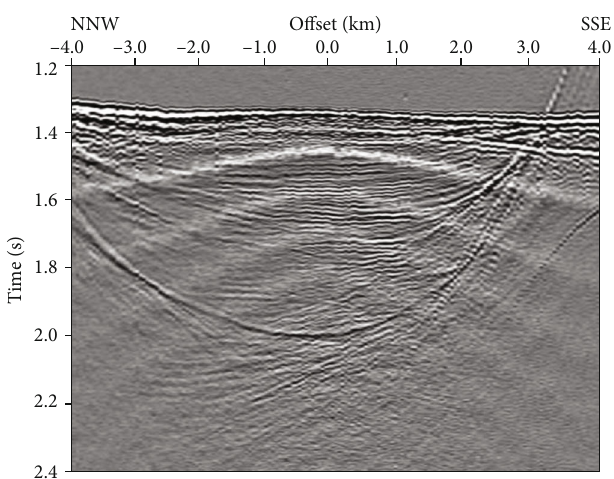
Figure 2: The OBS6 data with linear normal travel time correction after